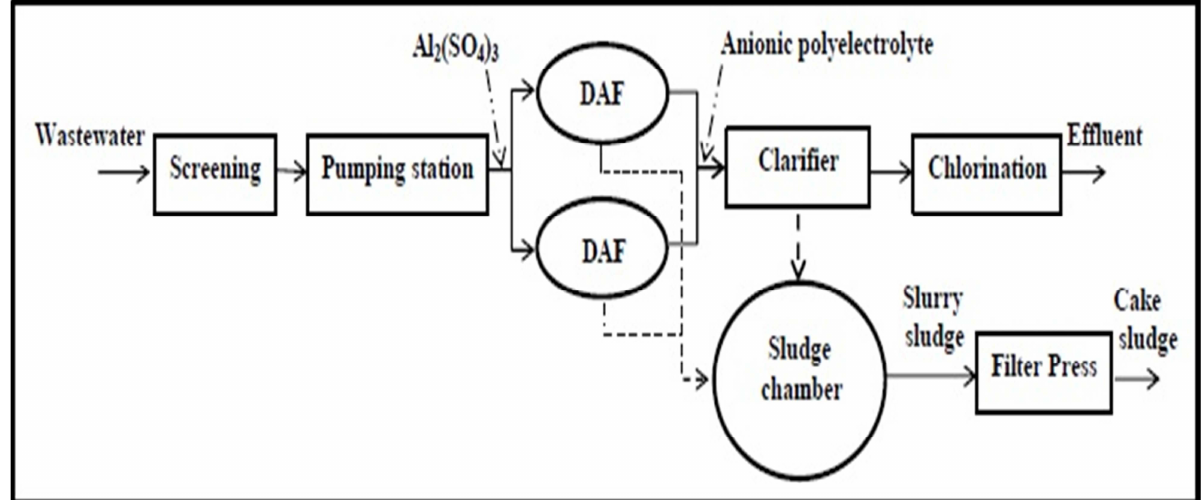
Figure 1. Treatment process of the steel wastewater in studied